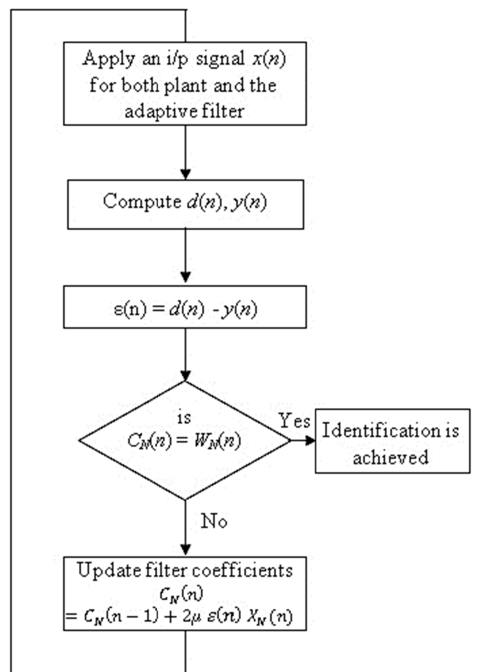
Figure 3. Gradient descent on a one-dimensional projection of a quadratic performance function.